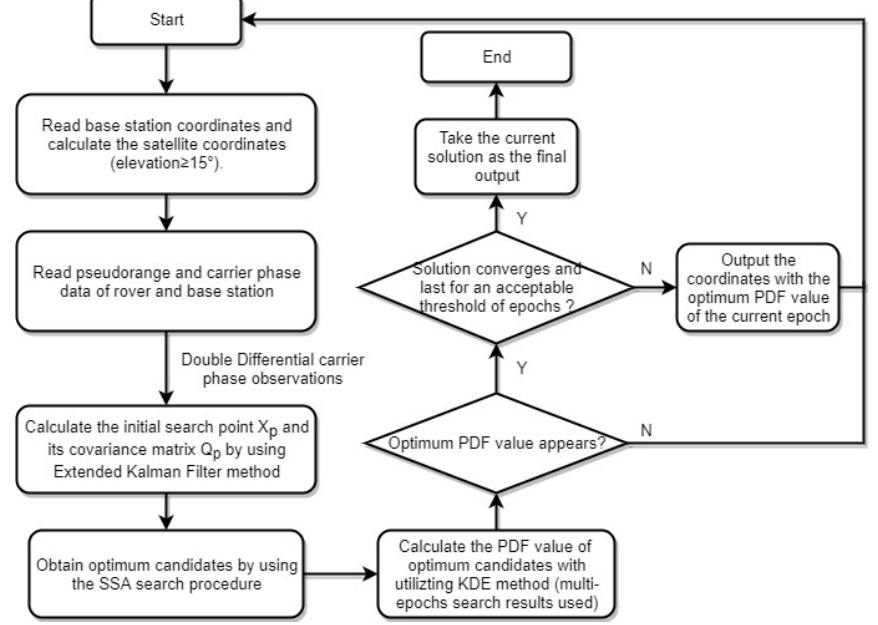
Figure 1. The whole procedure of the Segmented Simulate Annealing Modified Ambiguity Function Approach (SSA-MAFA)